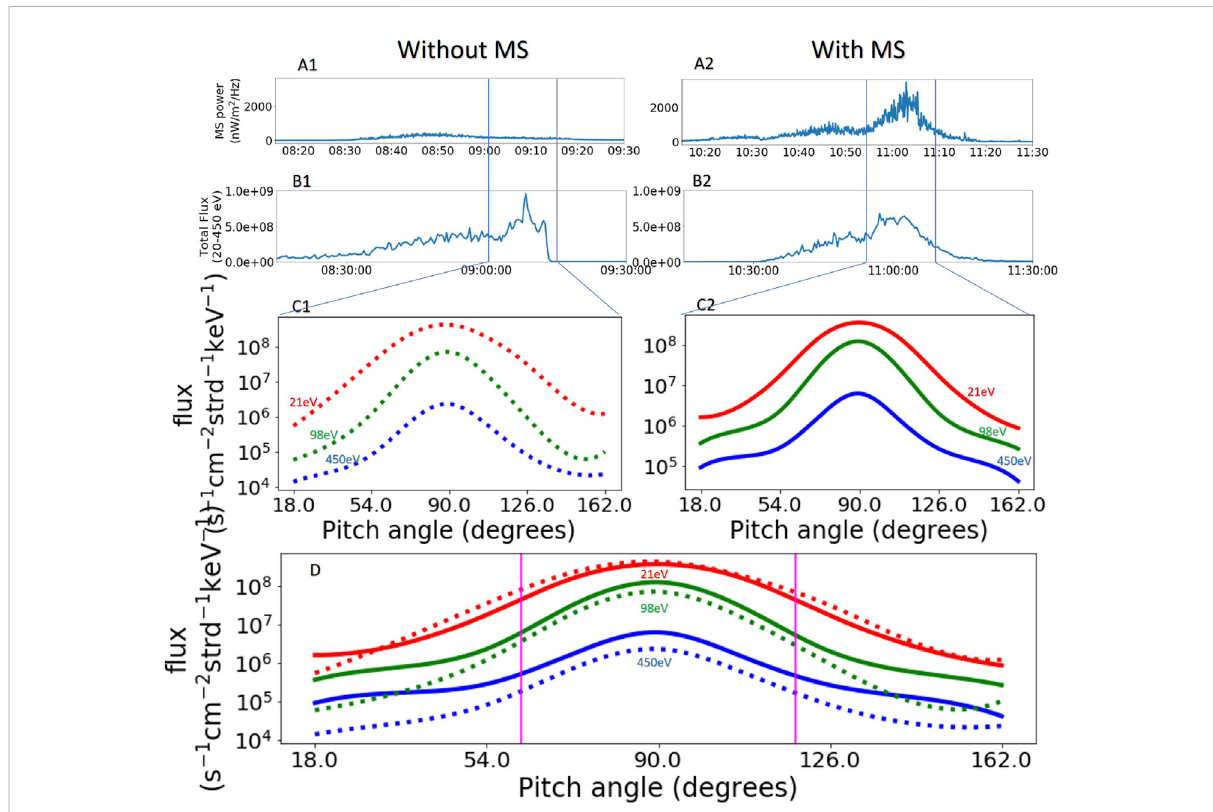
FIGURE 5 Comparison of pitch angle distribution of thermal/suprathermal protons in the presence and absence of MS waves. Panel (A1,A2) shows the Poynting fl ux of MS waves. Panel (B1,B2) shows the fl ux density of protons in the energy range of 20 – 450 eV. Panel (C1,C2) shows the pitch angle distributions of protons at energies of 21 eV (red), 98 eV (green), and 450 eV (blue). Distribution plots of panel C1 (dotted) and C2 (solid) are overplotted in panel (D) for comparison. Magenta vertical lines on panel D marks the regions of pitch angles around 90 ° beyond which the shapes of the distribution (solid and dotted lines) differ substantially for higher energies (green and blue